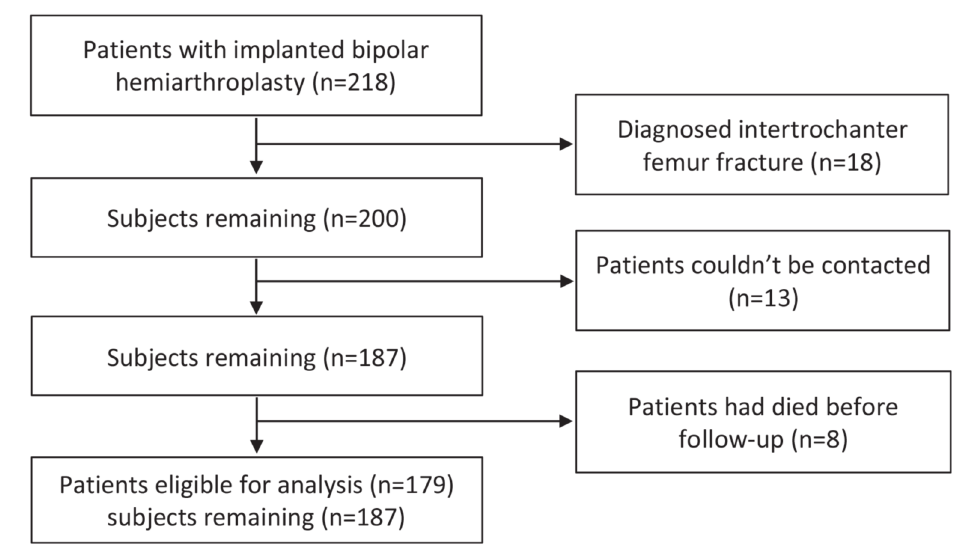
Flowchart of the patient selection Fig. 1: